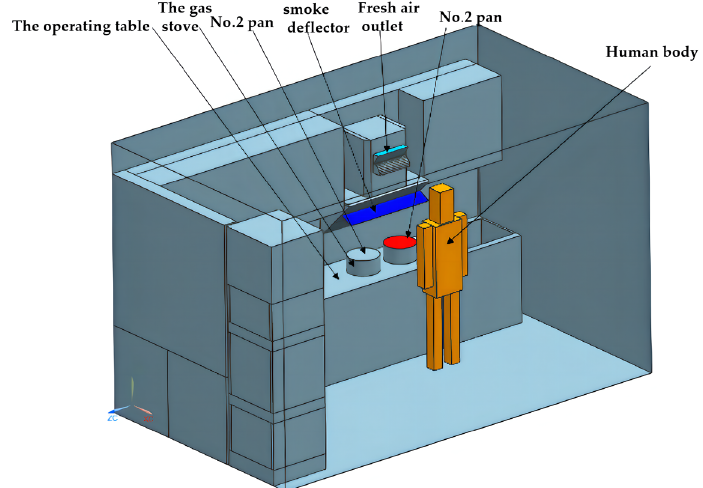
Figure 2. 3D geometric model of the experimental kitchen.